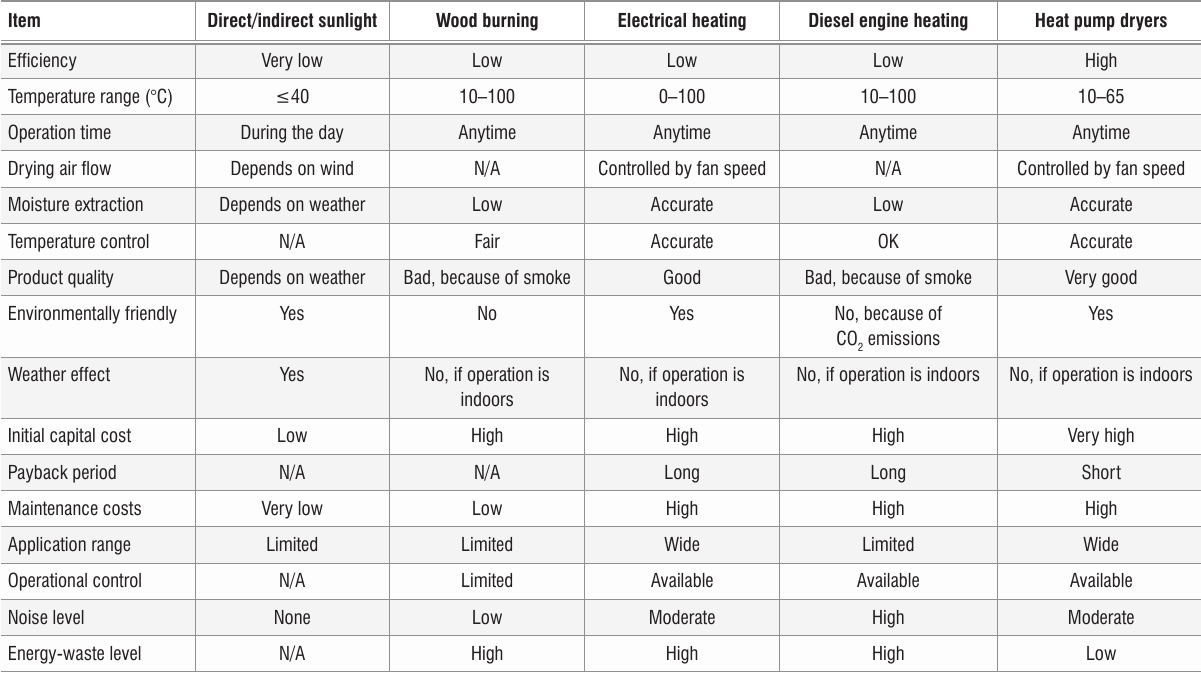
Comparison of heat pump drying with traditional South African drying methods